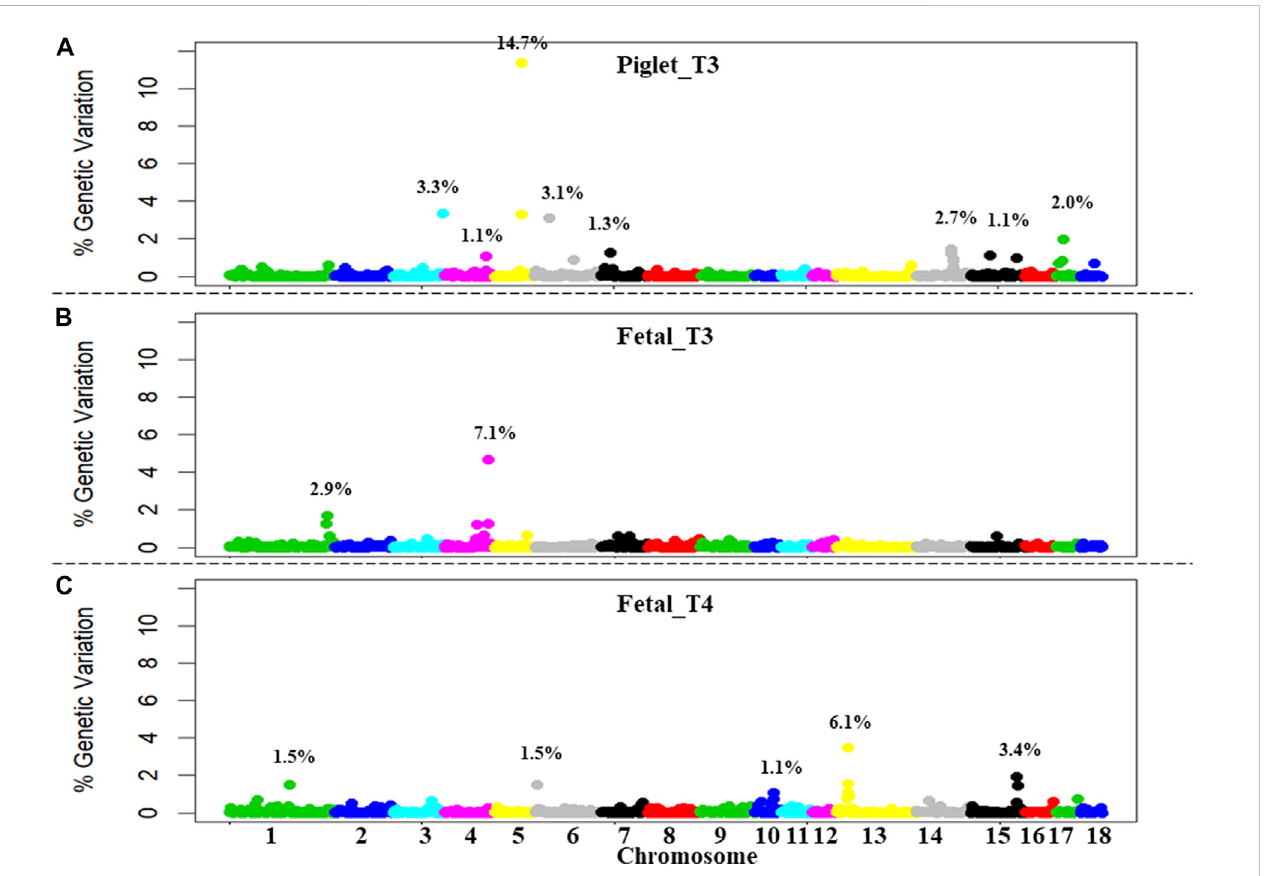
FIGURE 1 Genome-wide association study (GWAS) plot of the percentage of GV for thyroid hormone levels measured following PRRSV2 challenge in piglets and fetuses. (A) Triiodothyronine(T3)levels weremeasuredinpiglet serumat11DPI(piglet_T3). (B) T3levels weremeasuredinfetalserum at12or21DPMI(fetal_ T3). (C) Thyroxine (T4) levels were measured in fetal serum at 12 or 21 DPMI (fetal_T4). Results show the percentage of GV from 0% to 12% explained by each non-overlapping1-Mbwindow.Windowsareordered,labeled,andcoloredbychromosome(SSC1-18).Signi fi cantQTL(1ormoreconsecutivewindows explaining ≥ 1% of the genetic variation each) are highlighted with the summation of total GV